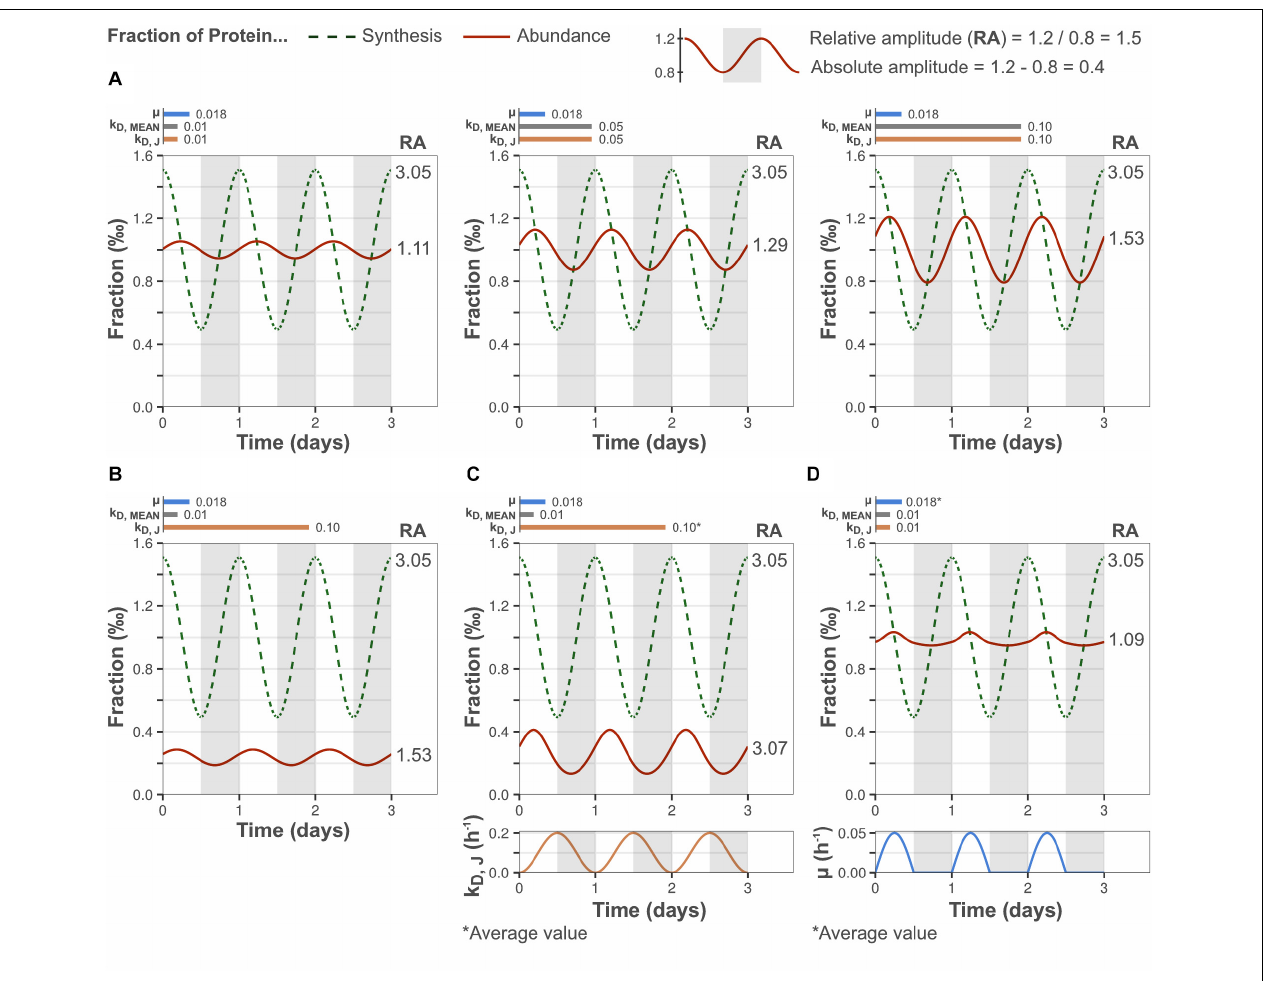
Frontiers in Microbiology |